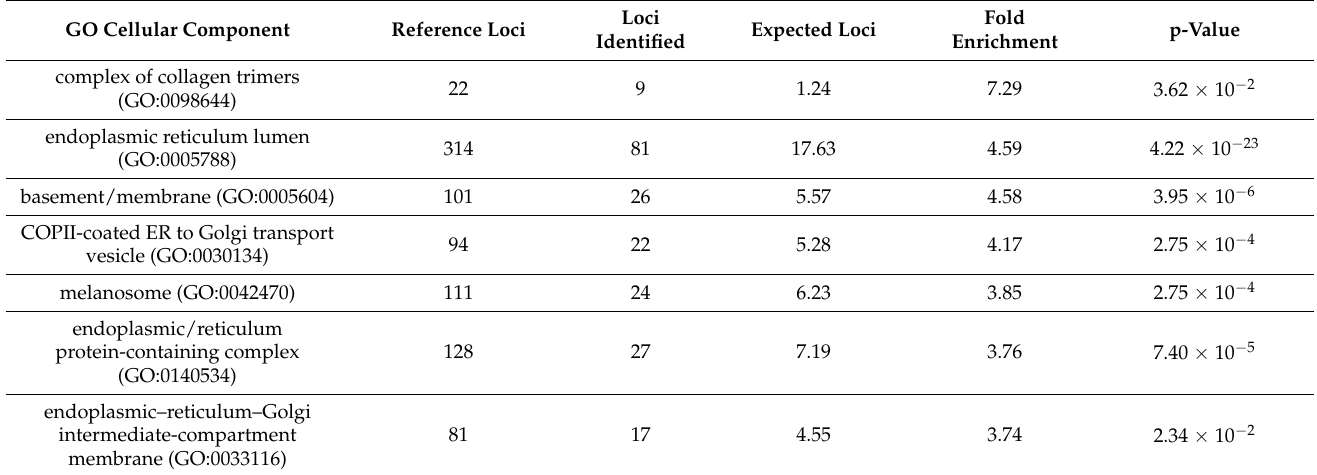
Table 3. GO cellular component analysis with Fisher’s exact test and Bonferroni correction showing the top seven systems by highest fold enrichment using all loci upregulated in hypoxia (n = 1261, p < 0.05).